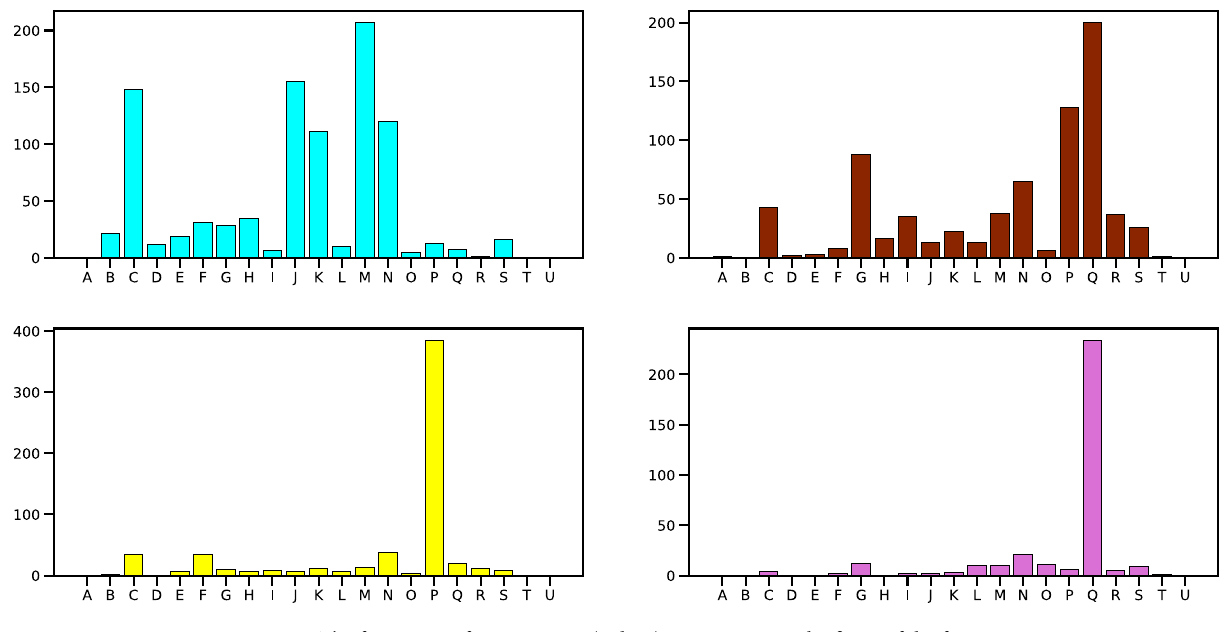
Figure 4. The frequency of NACE Rev.2 (1 digit) sectors among the firms of the four greatest communities in the validated network of Fig. 3. Please find the number of firms on the vertical axis; the colors of the different bar charts are the same as in the left panel of Fig. 3. The identification of the various NACE is in Table 3 in the Methods section. To enhance clarity, we anticipate here the most present sectors, which are: C) Manufacturing; G) Wholesale and retail trade; repair of motor vehicles and motorcycles; J) Information and communication; K) Financial and insurance activities; M) Professional, scientific and technical activities; N) Administrative and support service activities; P) Education; Q) Human health and social work